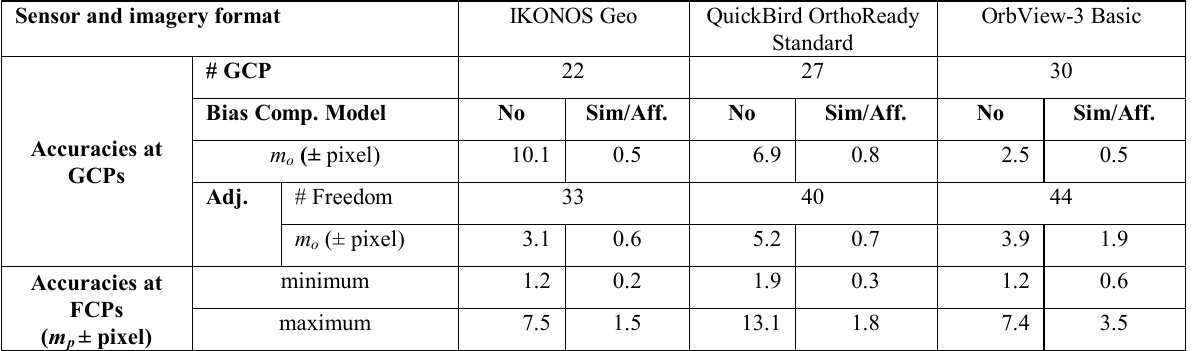
Table 3. Summary of the accuracies at GCPs and FCPs for 1st degree RFM (Topan